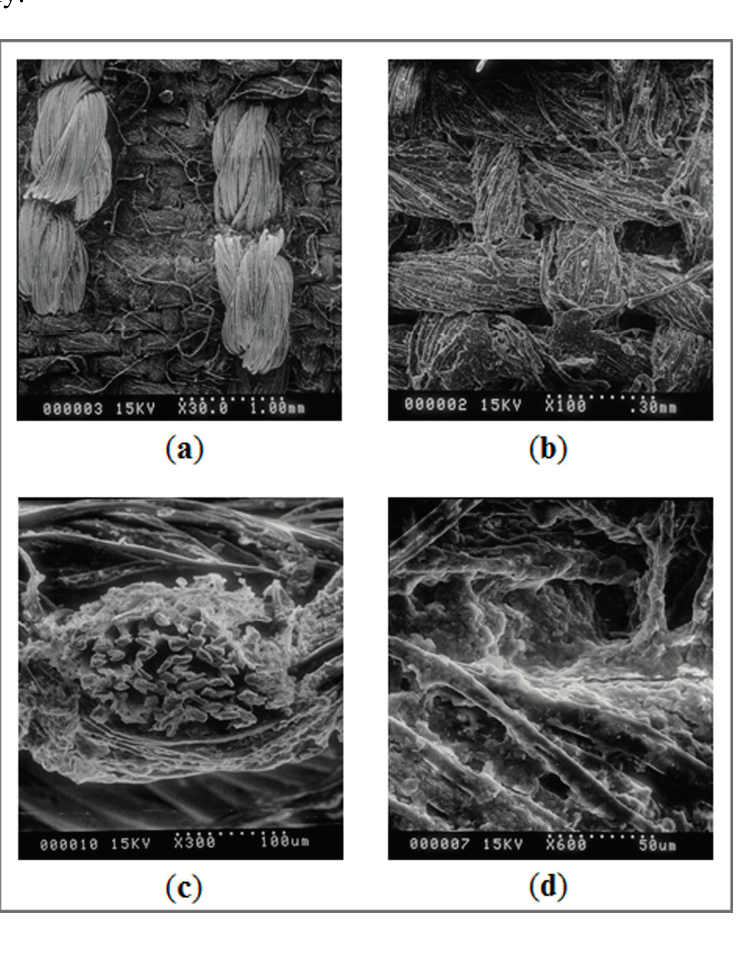
Figure 7. SEM pictures of ( a ) the surface of conductive thread (functioning as interdigitate electrodes) embroidered on the cotton satin fabric substrate at a magnification of 30×; ( b ) the surface of cotton satin fabric substrate at a magnification of 100×; ( c ) the cross-section of the conductive thread and the cotton satin fabrics as coated by a thick film of the polymer/SWNT-COOH nanocomposites materials 300×; and ( d ) the cross-section at 600×